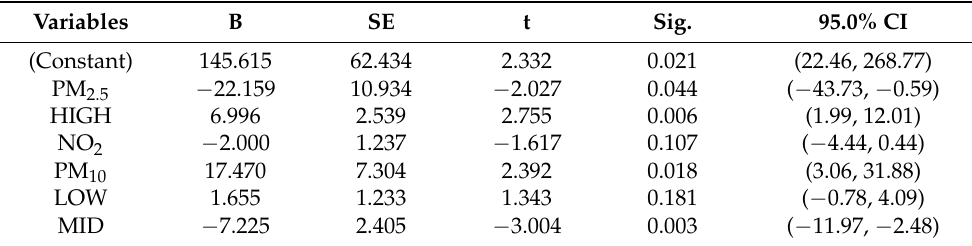
Table 3. The regression coefficients of joint noise level at low-, mid-, and high-frequency components and air concentrations of NO 2 , PM 10 , and PM 2.5 µ g/m 3 showing impact on hypertension rate.